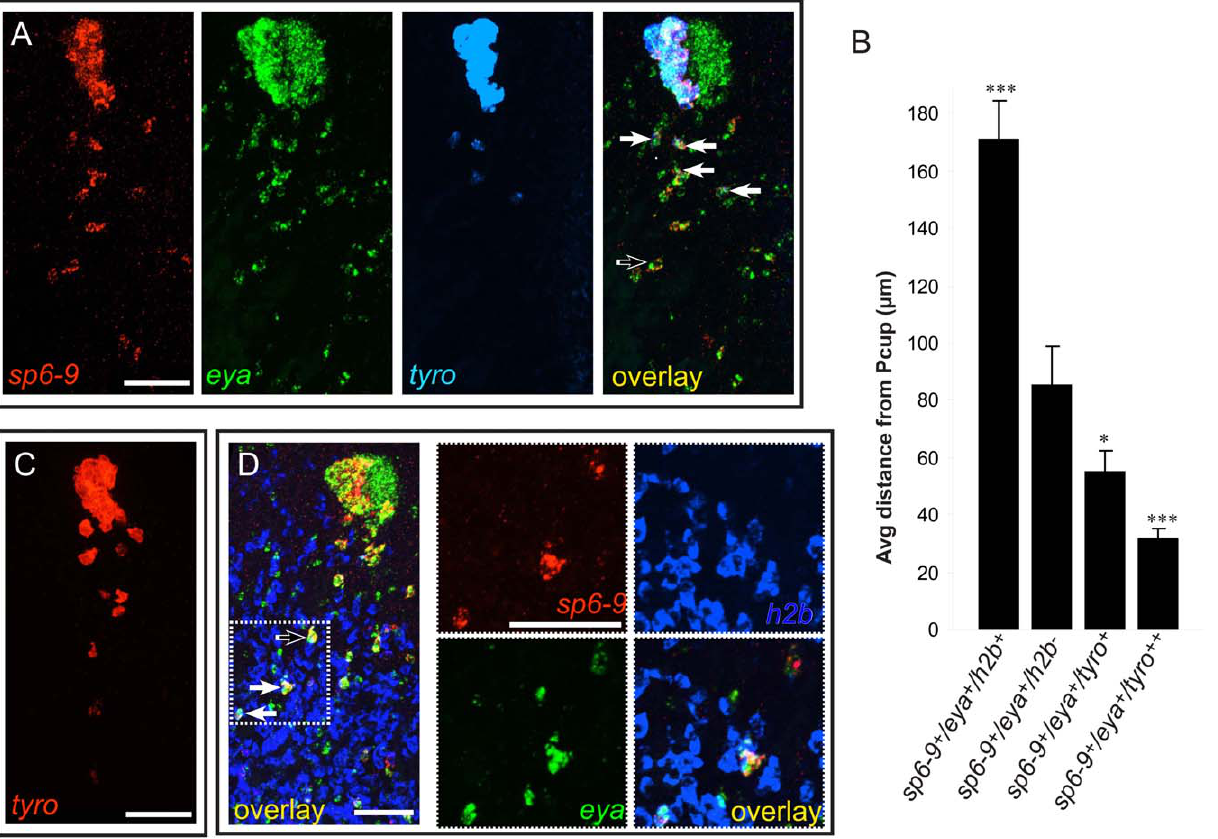
Figure 4. Optic cup trail cells exhibit a gradient of differentiation that correlates with distance from the cup primordium. Anterior is up in all images, and all eyes and trails are in blastemas at day 6 of regeneration following decapitation. (A) sp6-9 + / eya + trail cells strongly expressing tyrosinase are close to the optic cup. (B) Quantification of distance of trail cells from the Pcup (mean 6 s.e.m; n=4 eyes for each category; significance by two-tailed t-test is shown relative to second bar ( sp6-9 + / eya + ) *** P , .001, * P , .05). tyro ++ indicates strong, non-granular signal. (C) Weak tyrosinase expression can be detected in cells far from the optic cup. (D) Some sp6-9 + / eya + cells express the proliferation marker histone h2b . Solid arrows show triple-positive cells and the open arrow shows double-positive cells. Scale bars, 50 m m.